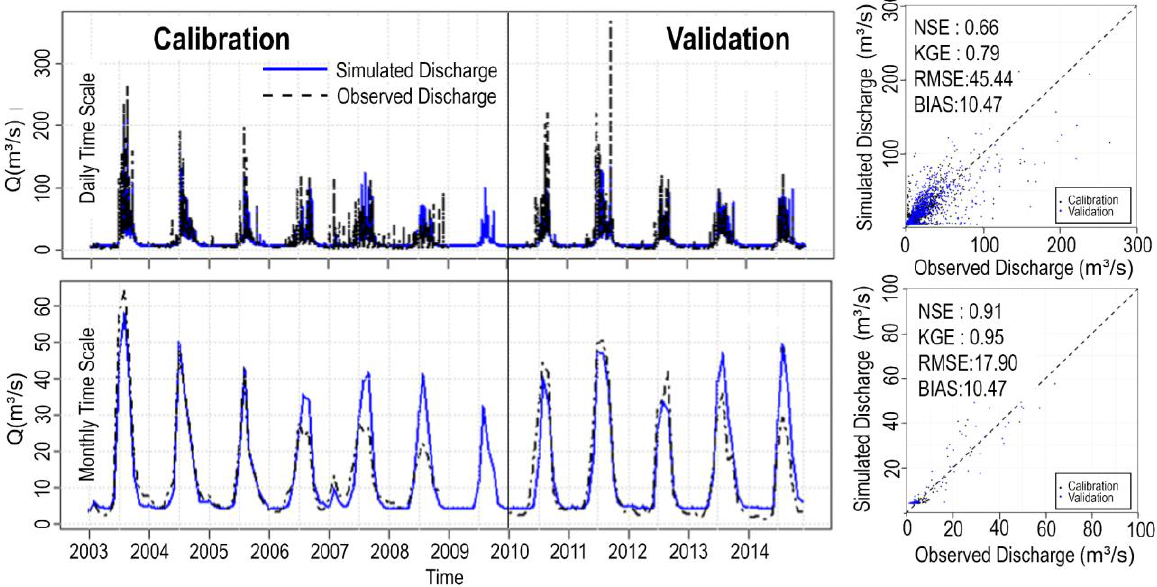
Figure 5. Time series and scatter plot of GR4J model-based simulated and gauge-based observed discharge at the outlet of Simat Khola River Basin during a calibration (2003 to 2007) and validation period (2010 to 2014) daily and monthly basis along with model performance indicators.